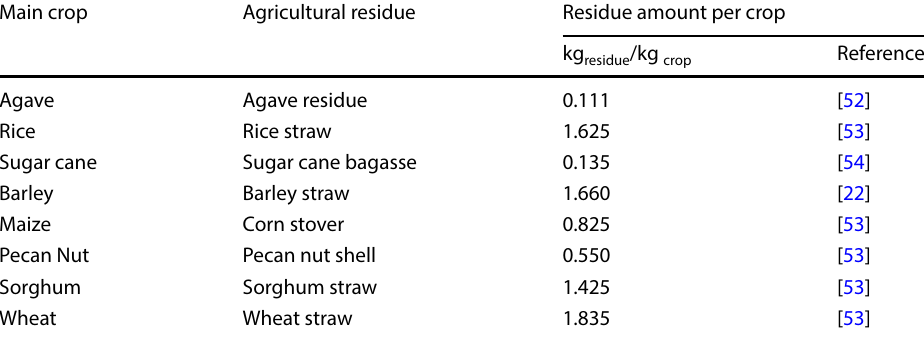
Main crop Agricultural